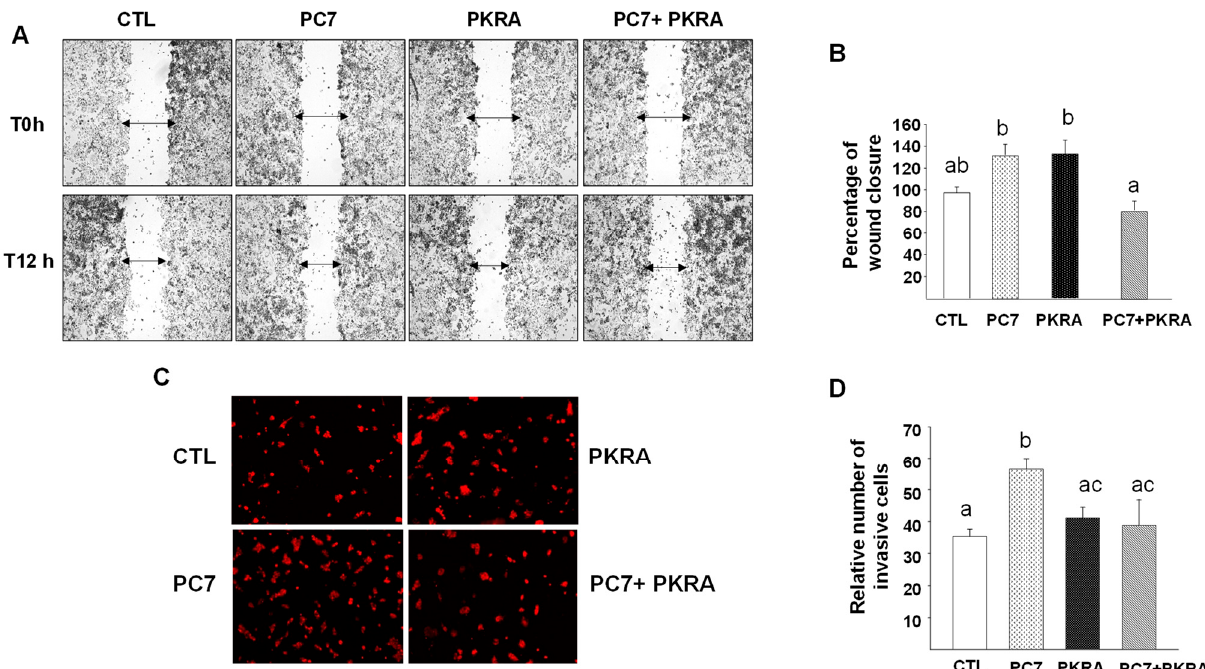
Figure 7. Effect of prokineticin antagonists’ on RCHO-1 migration and invasion. ( A ) depicts photographs of wounded RCHO-1 cells at 0 (T0) and 12 h (T12 h) post-wounding. The cells were treated at T0 with PC7 (1 µM) or PKRA (1 µM) or both. ( B ) shows a graph that reports the percentages of wound closure after 12 h of treatment. ( C ) reports microphotographs of RCHO-1 cells prelabeled with acetylated low-density lipoprotein (Dill) cultured on Matrigel-coated HTS fluroBlok transwell inserts and treated or not with antagonists. ( D ) depicts the % of invading cells upon treatment with PC7 (1 µM) or PKRA (1 µM) or both. Data are presented as means ± SEM. p < 0.05. Bars with different letters are significantly different from each other.